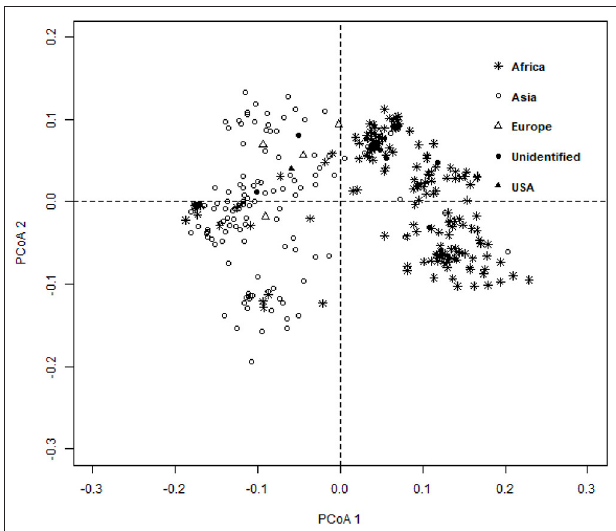
FIGURE 4 | Principal coordinates analysis (PCoA) based on the modified Roger’s distance of finger millet diversity